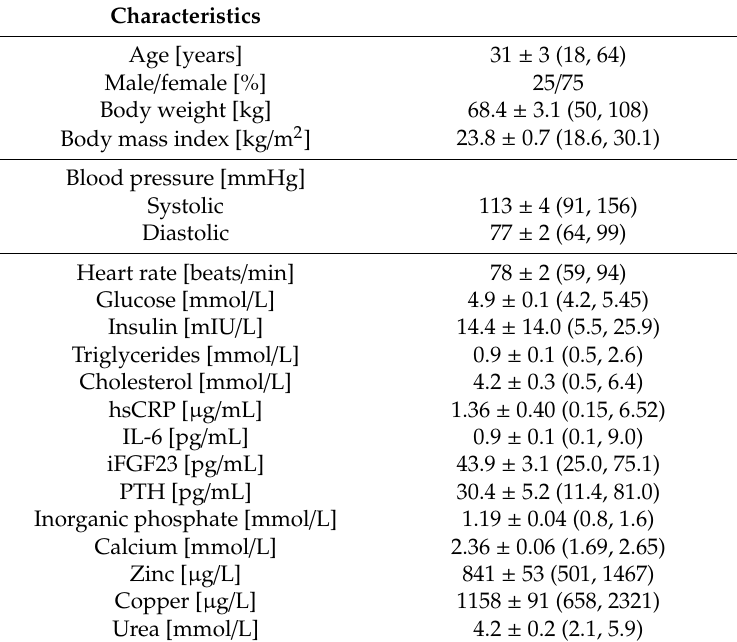
Table 4. Characteristics of study participants at